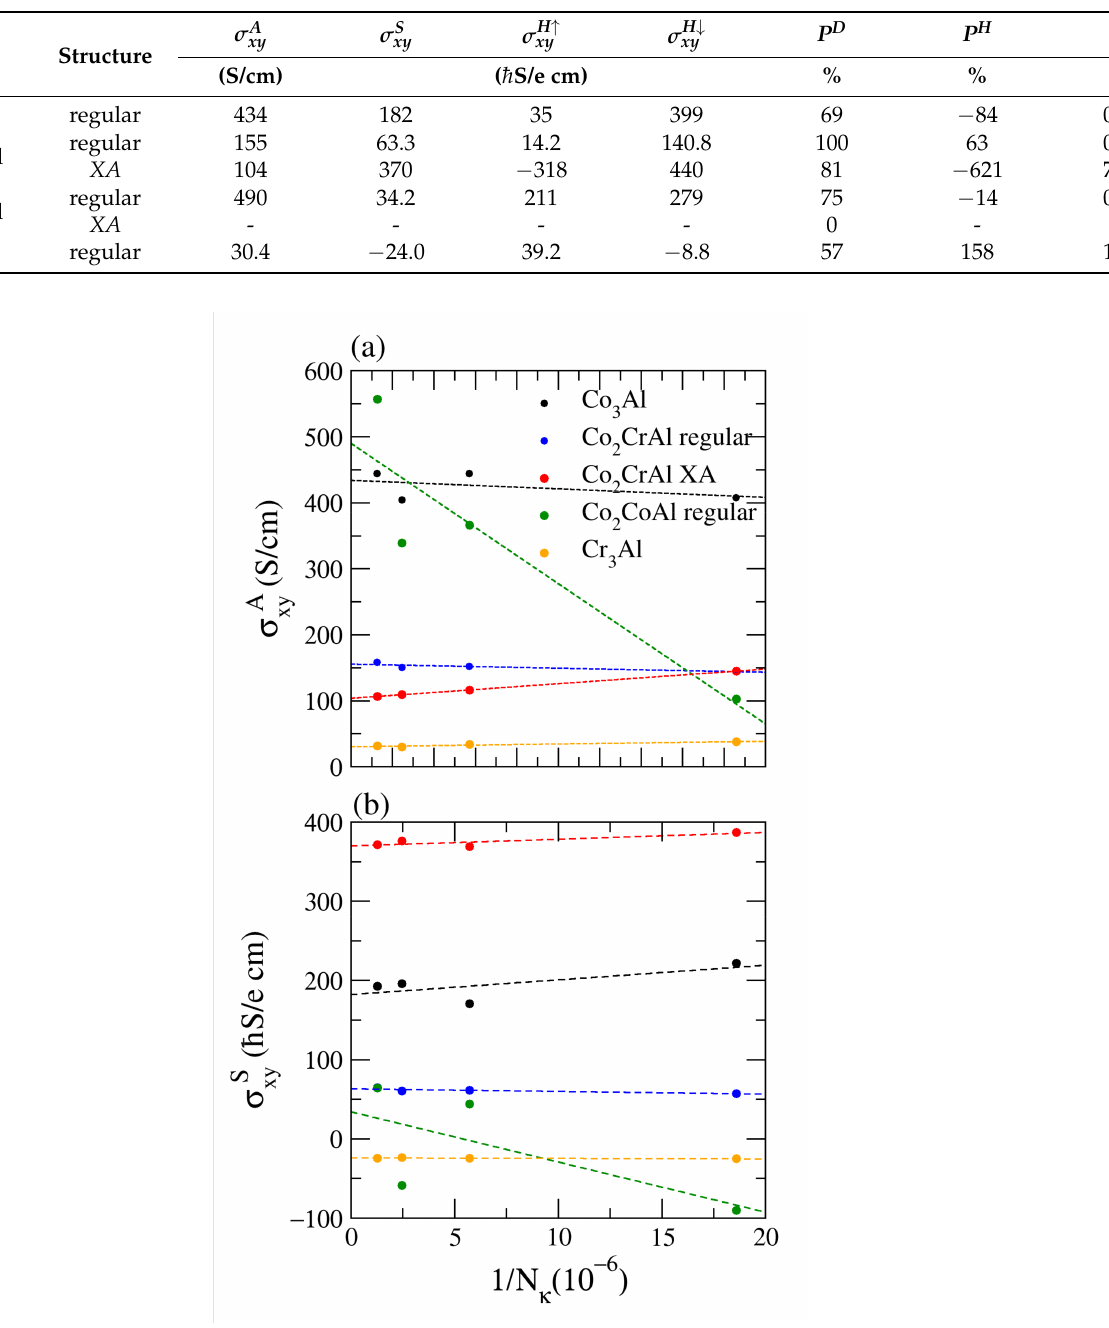
Figure 3. ( a ) Anomalous Hall conductivity and ( b ) spin Hall conductivity for Co 3 − x Cr x Al. The solid circles originate from the DFT calculations described in the manuscript and the dashed lines are the extrapolation results. The theoretical AHC and SHC are obtained from the y intersect of the dashed lines ( N k → ∞